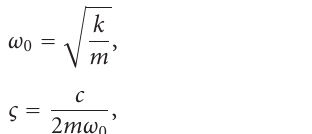
the IDFT of acquired vector samples. This range profile gives a one-dimensional mapping of scattering objects in the “view space” as function of their relative distance from the